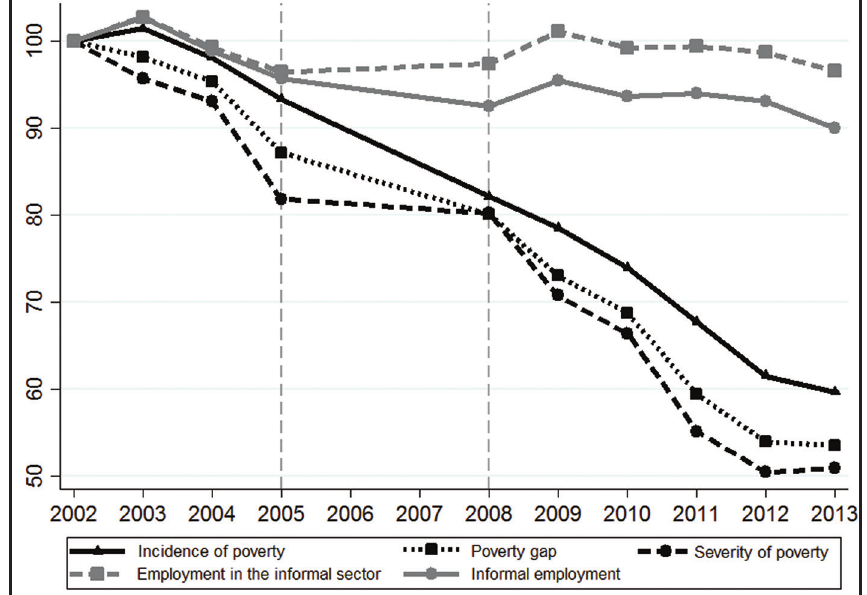
Figure 3 Changes in poverty indicators and informality rate in Colombia during 2002–2013.